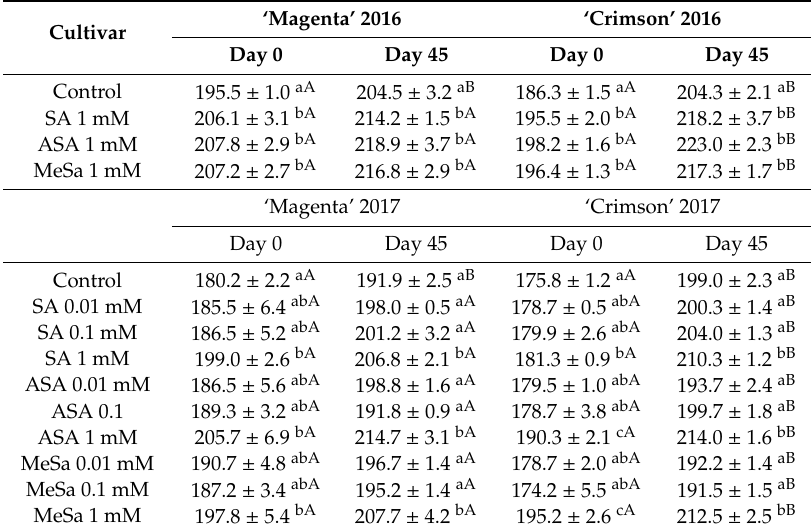
Table 2. Total soluble solids (g · kg − 1 ) at harvest (Day 0) and after 45 days of storage at 2 °C (Day 45) in ‘Magenta’ and ‘Crimson’ table grapes as affected by preharvest salicylic acid (SA), acetyl salicylic acid (ASA) and methyl salicylate (MeSa) treatments in 2016 and 2017 experiment.